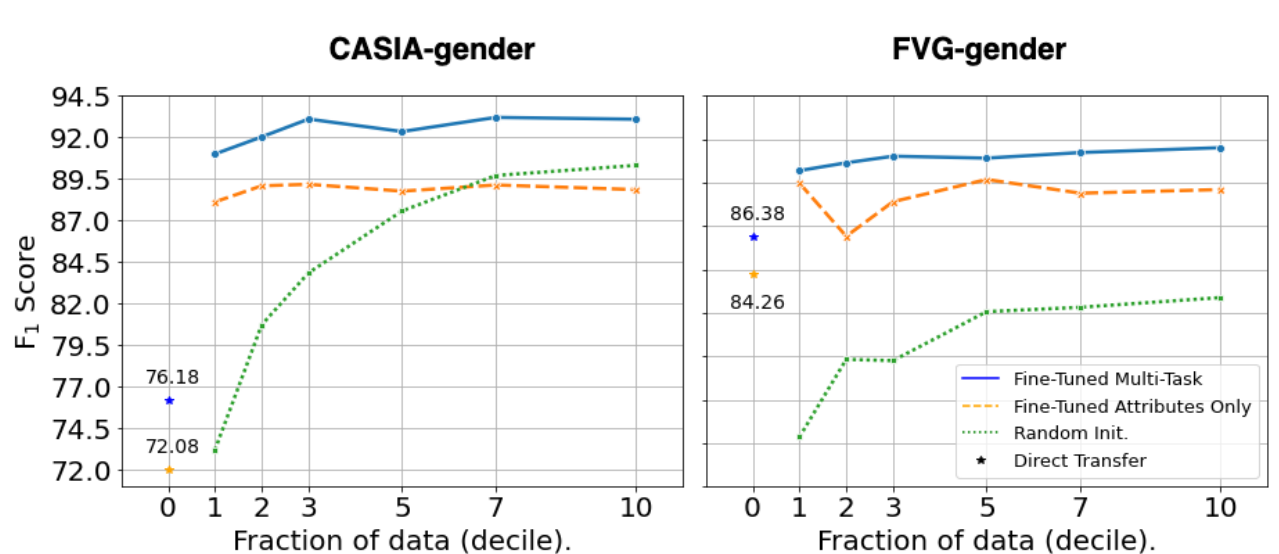
Figure 7. Fine-tuning results for GaitFormer on CASIA-gender and FVG-gender, trained on pro- gressively larger samples of the datasets. Compared to a randomly initialized network, GaitFormer benefits significantly from fine-tuning in extremely low data regimes (e.g., 10% of available anno- tated data). Compared to only pretraining on predicting attributes (Attributes Only), the Multi-Task network has consistently better performance across all fractions of the datasets.